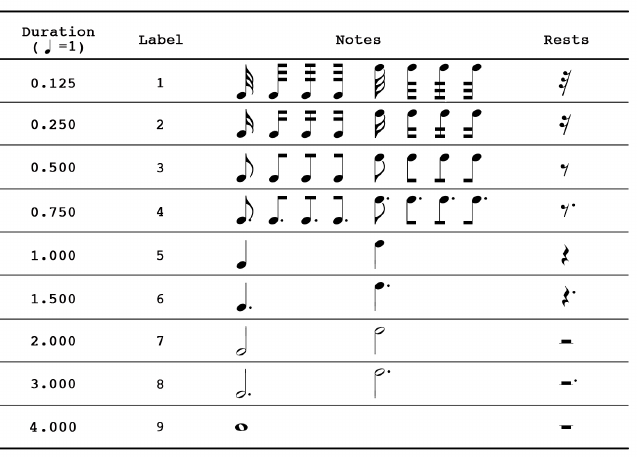
Figure 3. Encoding the duration into discrete categories. Nine kinds of durations were used in our work, and each duration corresponded to a different note. The duration was encoded as a label between 1 and